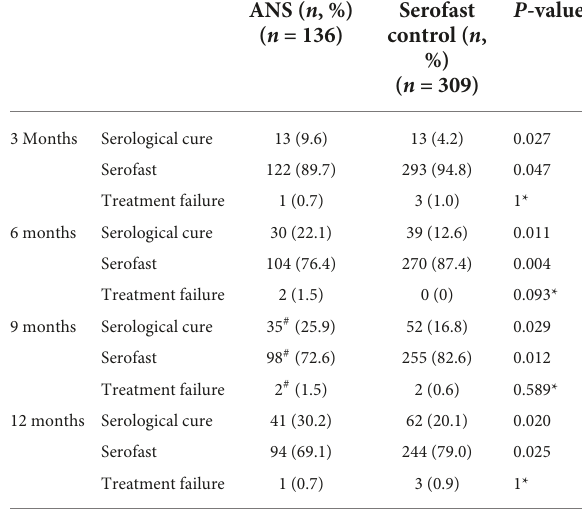
TABLE 2 Comparison of serological responses between the ANS group and the serofast control